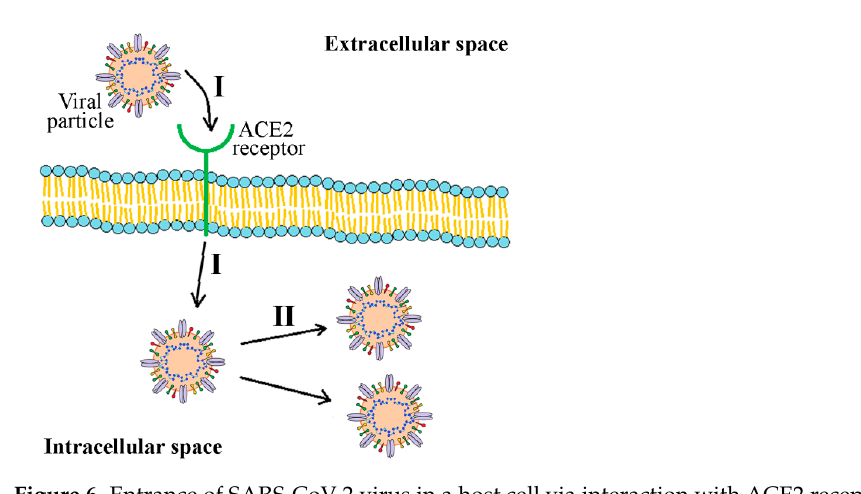
Figure 6. Entrance of SARS-CoV-2 virus in a host cell via interaction with ACE2 receptor ( I ) and its subsequent internal replication ( II ). Polyphenols are shown to inhibit both modes of action.